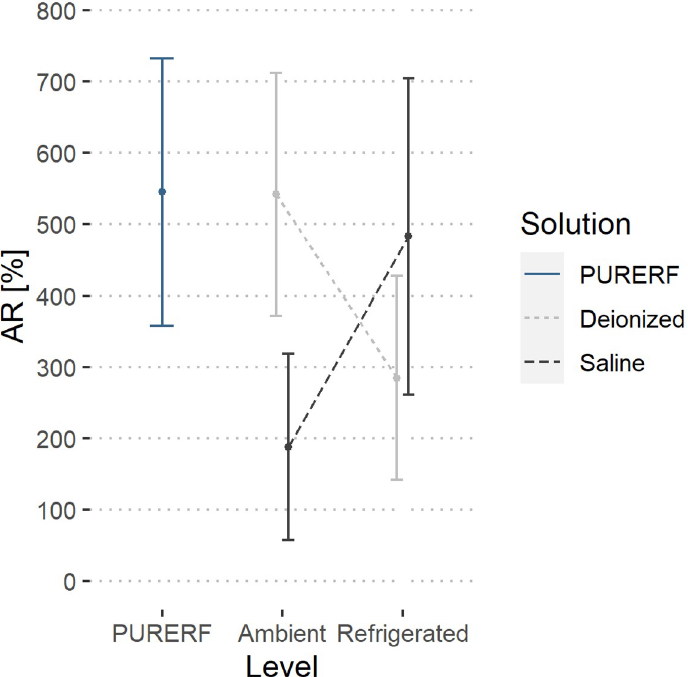
Fig 12. Estimated marginal averages of the AR indicator. The graph indicates no significant interactions for the solution type or the temperature. The AR index decreases in both solutions when refrigerated. This indicates a lower final